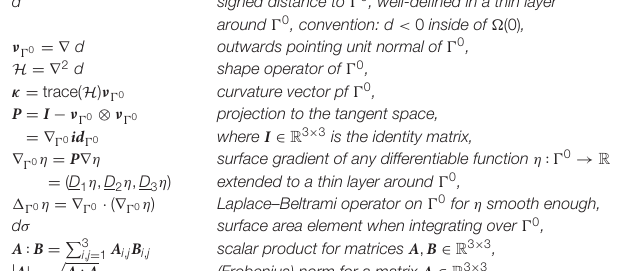
FIGURE 1 | Sketch of some objects defined in in sections 2.1, 4 for the abstract framework and the specific cell blebbing model, respectively. The cell membrane Ŵ ( t ) is parameterized by u over the initial surface Ŵ 0 which, unlike in this sketch, is closed and of spherical topology . Force densities arising from membrane tension, denoted f tension , point outwards in concave areas (as in the sketch) and inwards in convex areas. Linker molecules (indicated in orange) connect the membrane with the cortex, which is close to the initial surface and not explicitly indicated. They are modeled with a force density that points toward the initial surface when the molecules are stretched. The force vanishes if the linkers break. The pressure f pressure points in the direction of the unit normal ν Ŵ 0 of Ŵ 0 , which is the external unit normal of the cell in its initial